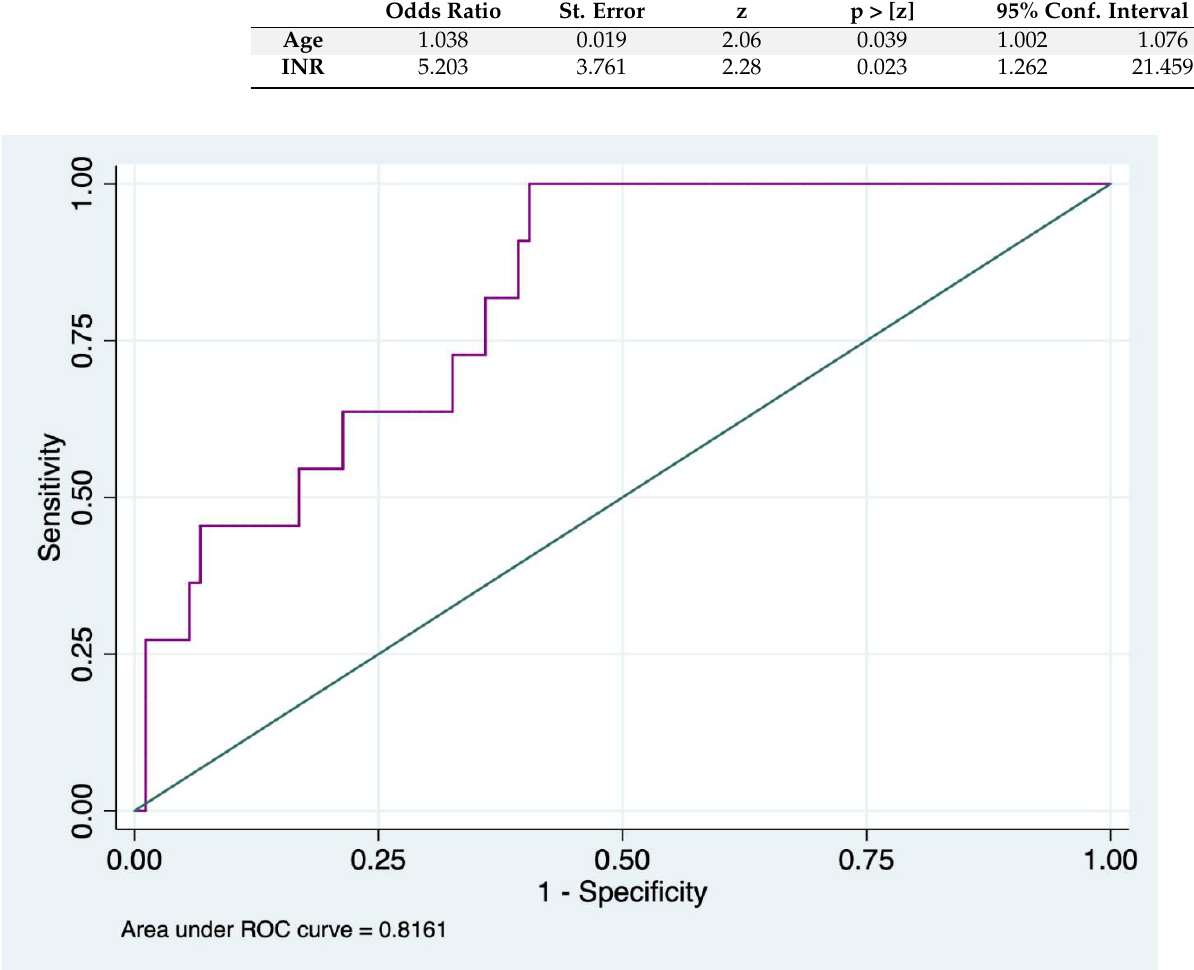
Figure 1. ROC curve analysis of D-dimer values to assess in-hospital mortality.